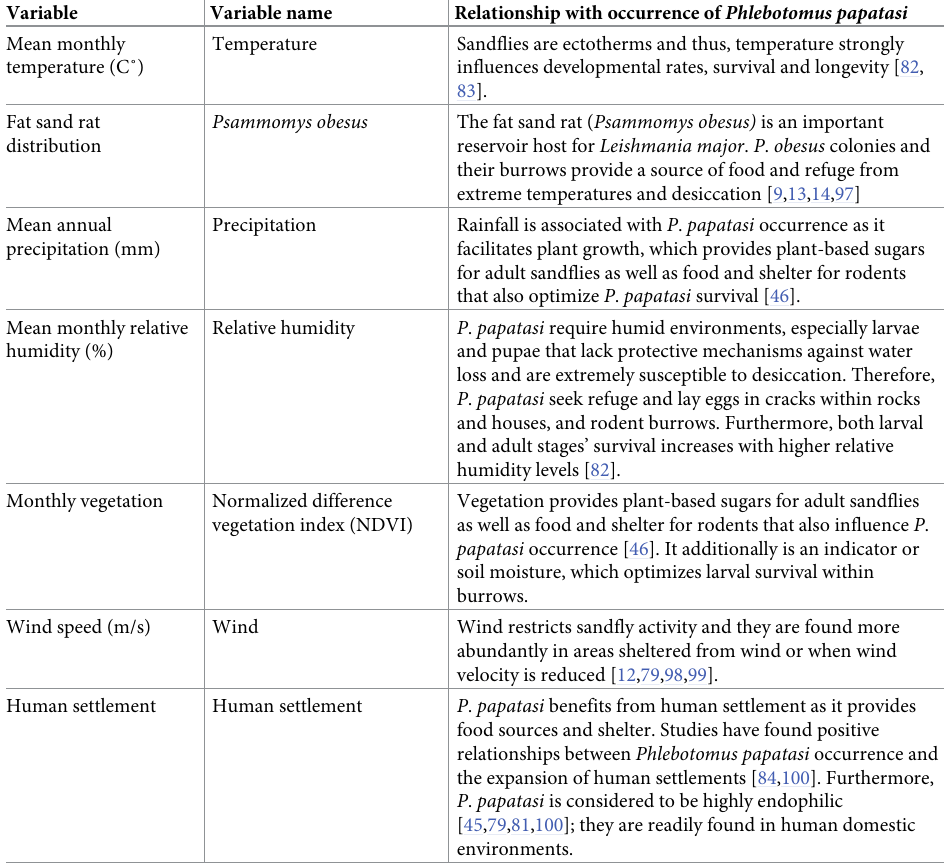
Table 1. List of model predictor variables. A description of variables identified by previous studies and publication sources as influencing the distribution of Phlebotomus papatasi and their relationship with its